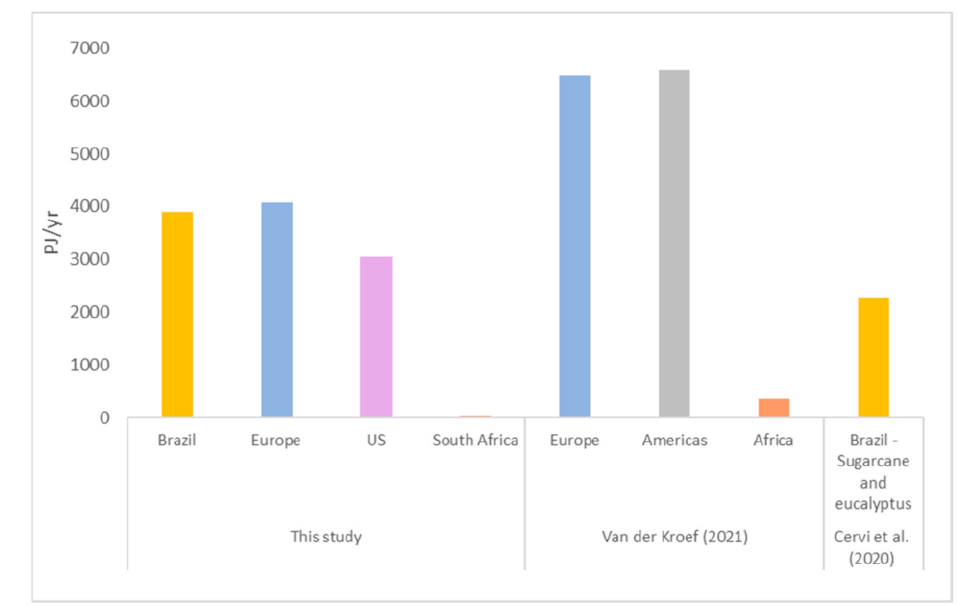
Figure 7. Biomass residues potentials compared to other studies. In addition, SVO total technical potential in Brazil totalized approximately 1000 PJ/year. Maps with biomass potential in each regional division were constructed (see Supplemen- tary Material) and kernel maps enabled the evaluation of bioenergy dispersion and the identification of hotspots in each region (Figures